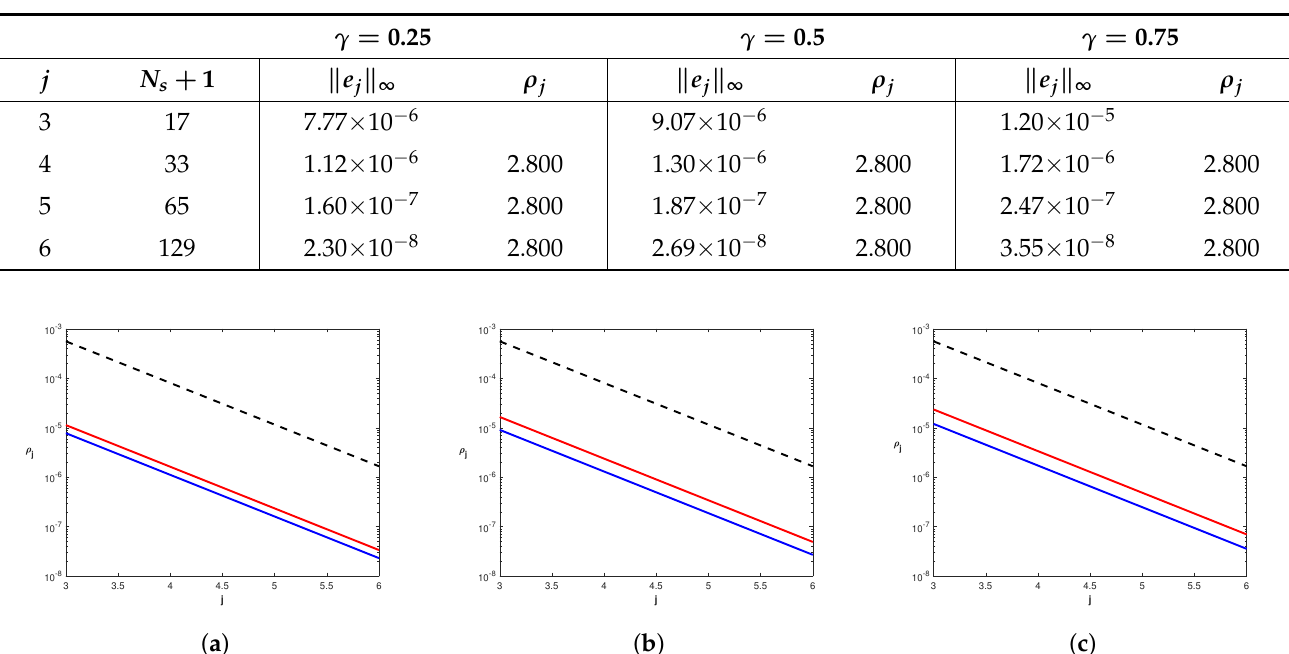
Table 3. Example 1: The infinity norm of the error and the numerical convergence order for different values of the fractional derivative γ and the refinement level j when using dQ 3 j y with r = 2 (cf. (27)). The number of collocation points is N s + 1 = 2 j + 1.